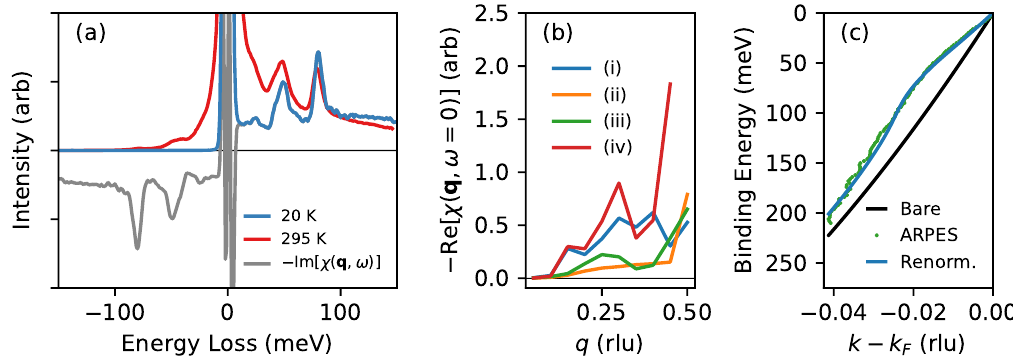
Figure 6: (a) Illustration of the antisymmetrization procedure for determining χ (cid:48)(cid:48) ( q , ω ) from the correlation function, S ( q , ω ) . The energy asymmetry of the M-EELS spectrum at q = 0 at 295 K (red) and 20 K (blue) is a consequence of the Bose factor (Eq. 5). The antisymmetrized spectrum representing χ (cid:48)(cid:48) ( q , ω ) is shown in gray. (b) Momentum dependence of the static susceptibility, χ ( q ,0 ) , at T = 20 K for the four momentum directions defined Fig. 5a. Note that χ ( q ,0 ) is purely real. (c) The calculated bare (black) and renormalized (blue) band dispersion of Bi2212 are compared to the measured ARPES data (Ref. [ 59 ] ). The renormalized electron self-energy was determined using a one-loop calculation using the experimentally determined χ (cid:48)(cid:48) ( q , ω )